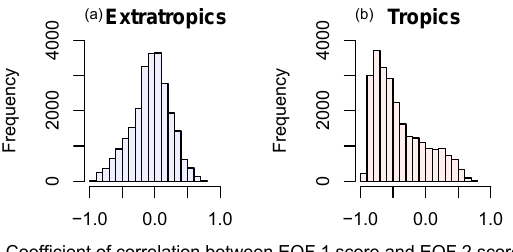
Figure 17. Histograms of the coefficient of correlation between EOF 1 and EOF 2 scores. Out of 79192 total inferred pix- els, 49902 pixels are selected by the condition SD(EOF 1 Score) < 0.02, SD(EOF 2 Score) < 0.02. The results in Figs. 12–14 are based on the data within the center six bins in these